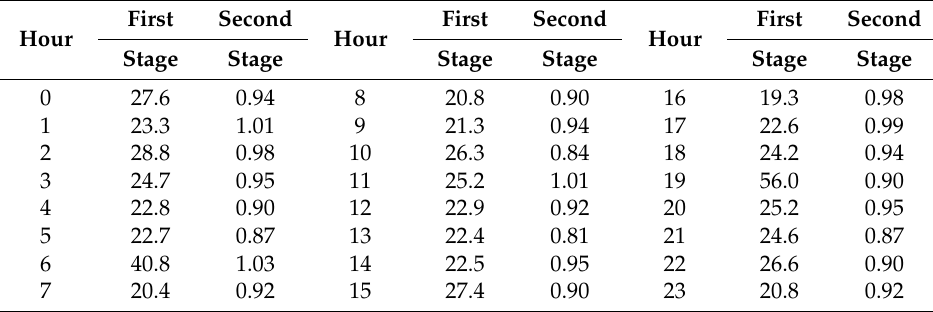
Table 6. Computational time